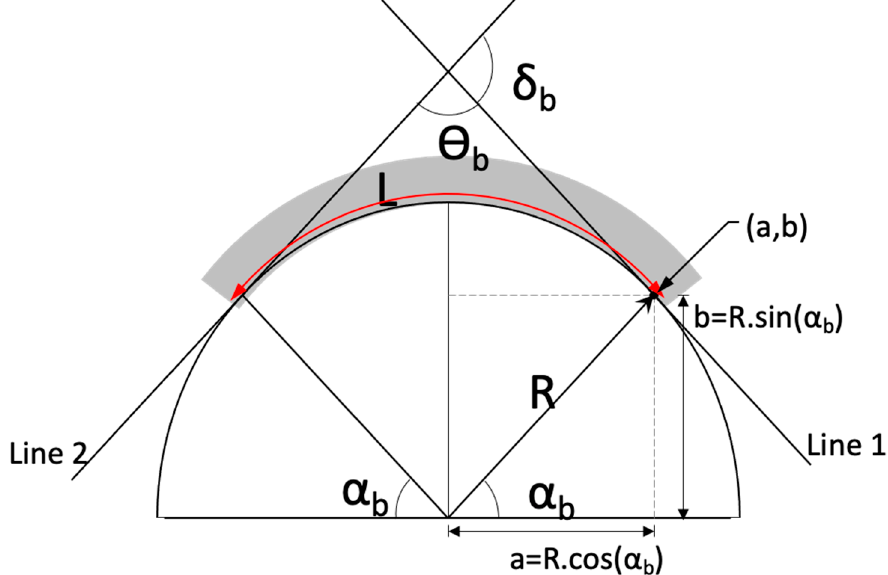
Table 1. Comparison between sensor sensitivity, linearity, and uncertainty when magnetized at 0.6